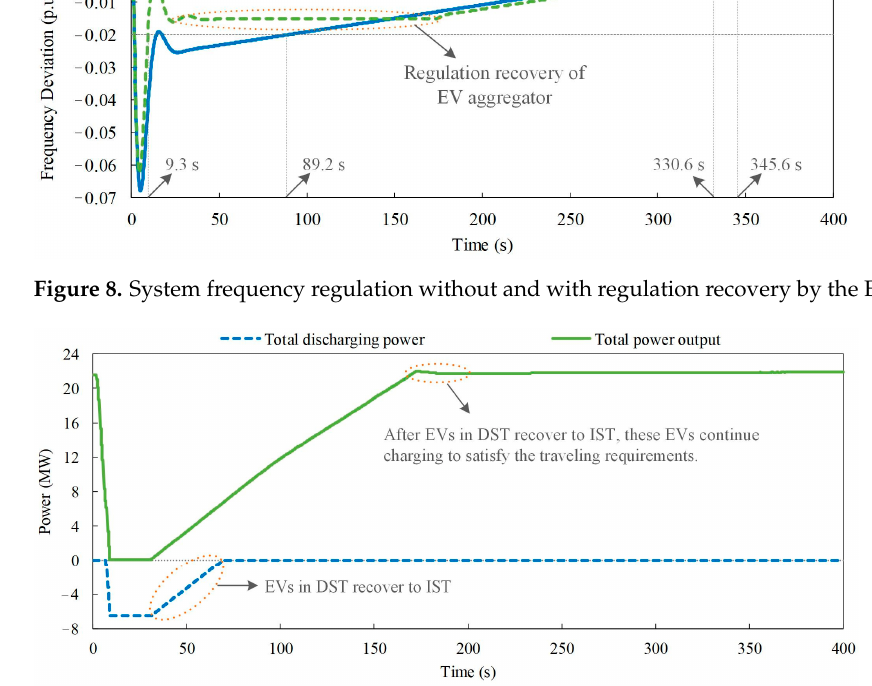
Figure 9. Total power output and total discharging power of the EV aggregator during the system frequency regulation with regulation recovery.